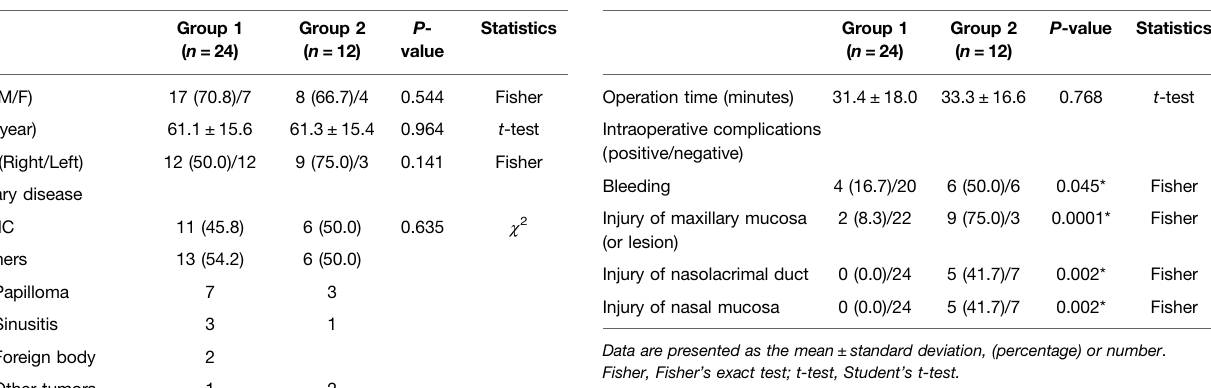
TABLE 1 | Demographic data of Groups 1 and 2. TABLE 2 | Operation time and intraoperative